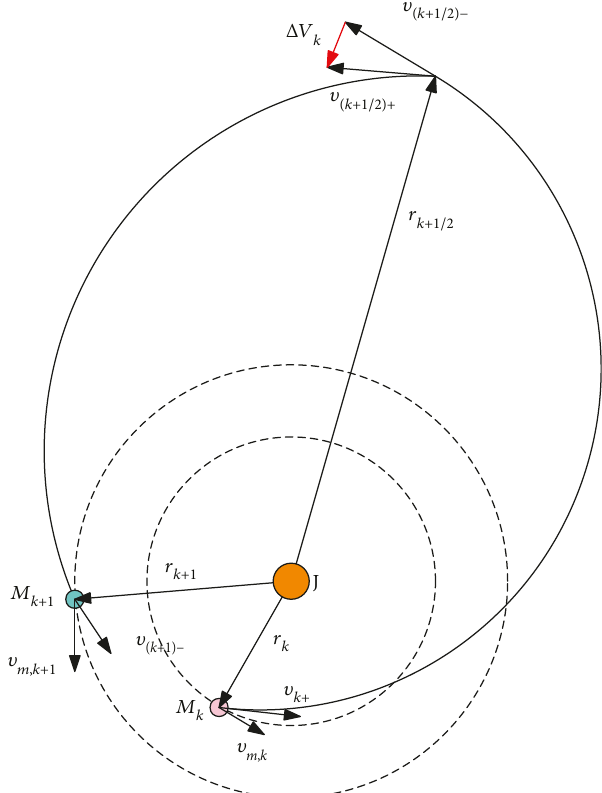
Figure 1: Trajectory sketch for an intermediate